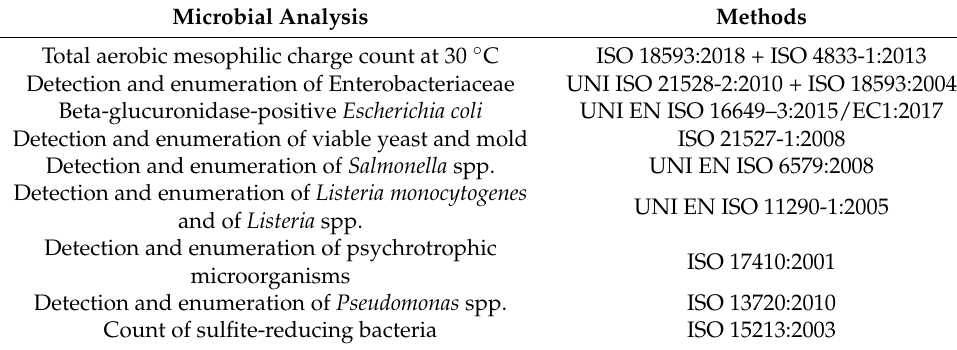
Table 3. Microbiological methods used in the analysis of P. lividus before and after HPP processing. Microbial